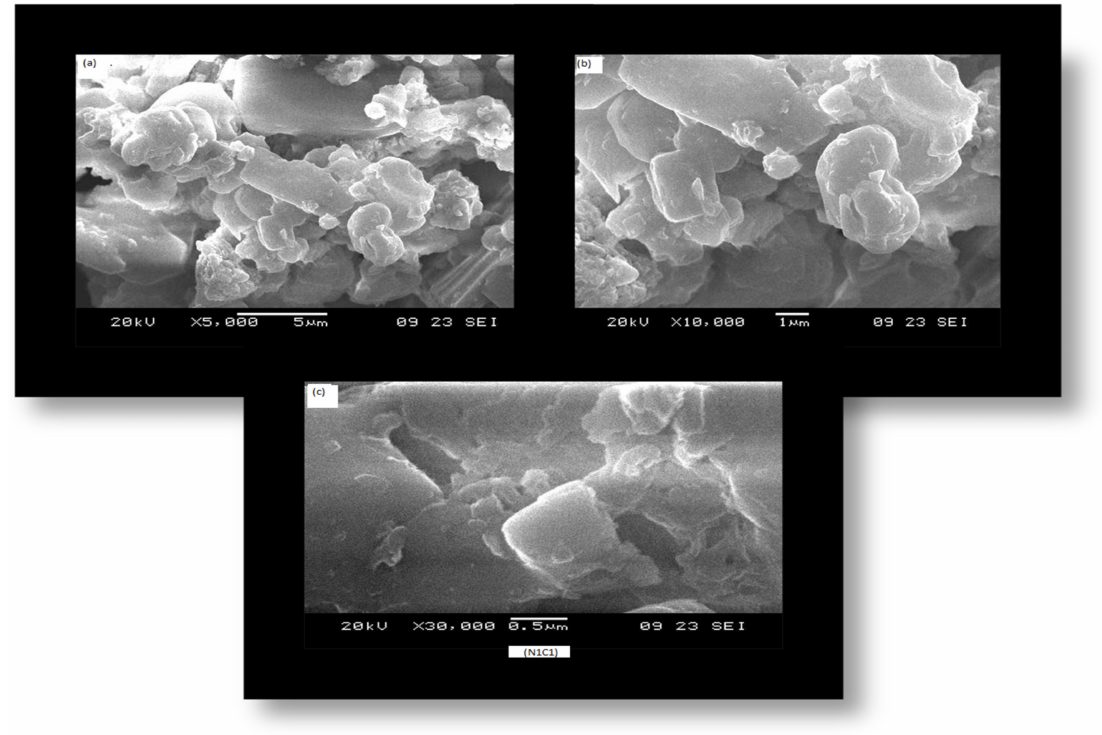
Figure 3. SEM images of cobalt oxide nanoparticles synthesized from N1C1 microbial strain isolated from soil at different magnifications.